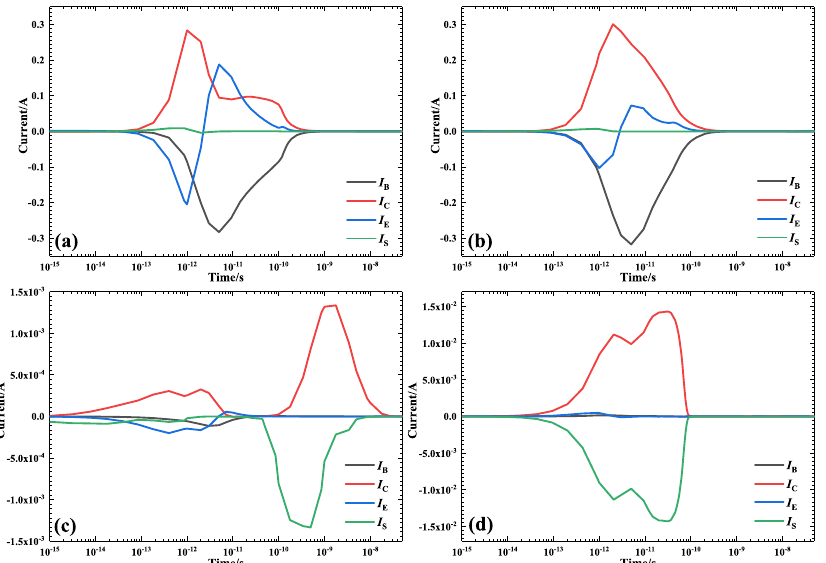
Figure 4. The current change in each terminal with time as heavy ions irradiate the center of emitter ( a ), base ( b ), collector ( c ) and substrate ( d ) of the SiGe